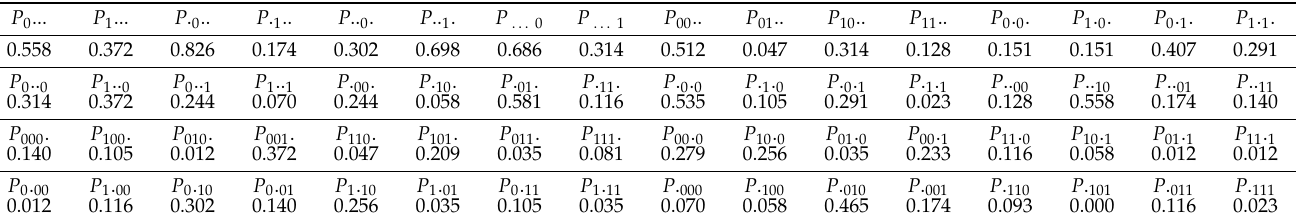
Table 6. Different situation probability of risk factor coupling for accidents in DFP adjacent to existing underpass